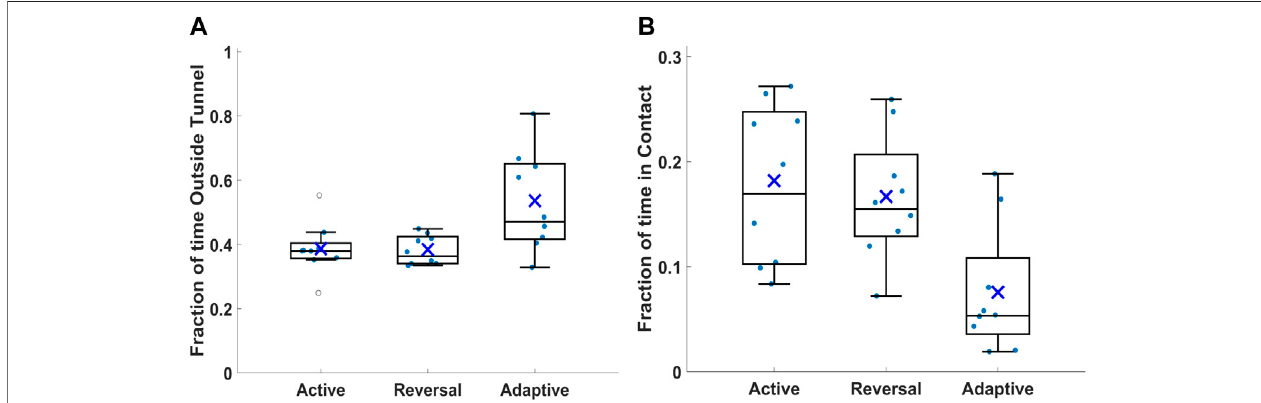
FIGURE 8 | Time spent in various states by individual robots, for the three protocols: Active, Reversal and Adaptive. (A) Time spent at the resting and deposition areas (B) Time spentincontactwithotherrobotswhile inthetunnel. Boxesspan25 th to75 th percentile,whiskersarebetweentheminimalandmaximal values,innerline is the median, × for means, and circles (solid and empty) represent actual data